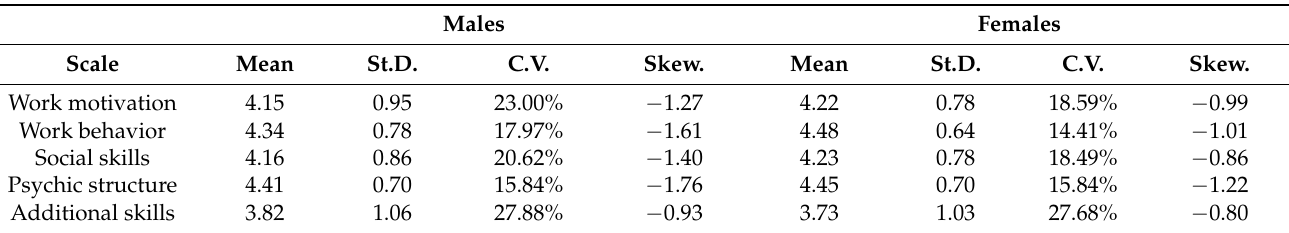
Table 4. Means, standard deviations (St.D.), coefficients of variation (C.V.) and skewness (Skew.) of the overall answers of the different scales of the questionnaire when the sample is differentiated by gender.